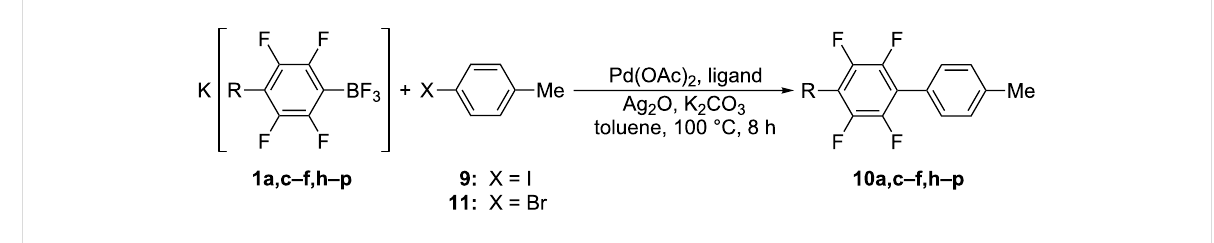
Scheme 4: Synthesis of biphenyls 10a,c–f,h–p .